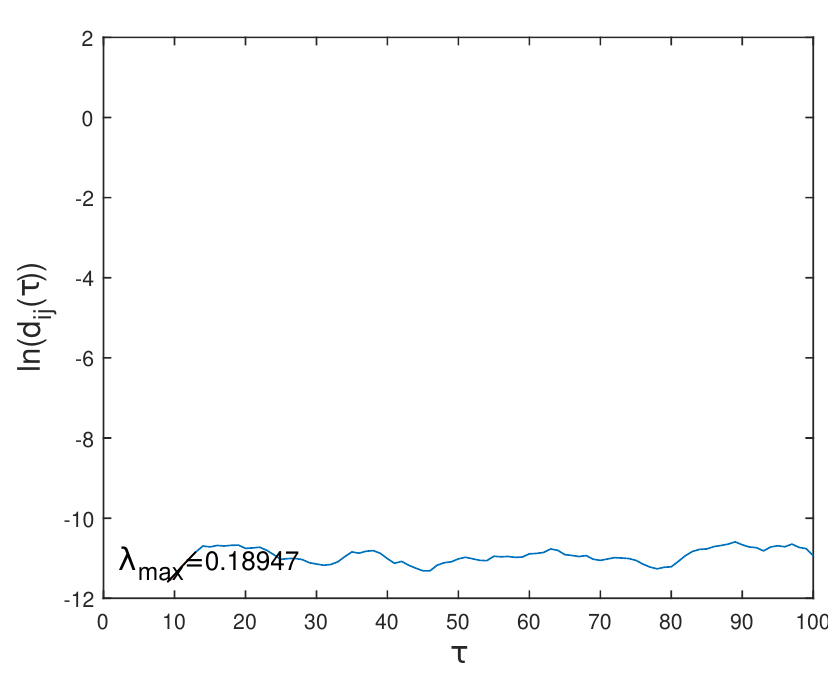
Figure 3. Lyapunov exponent of the Ikeda